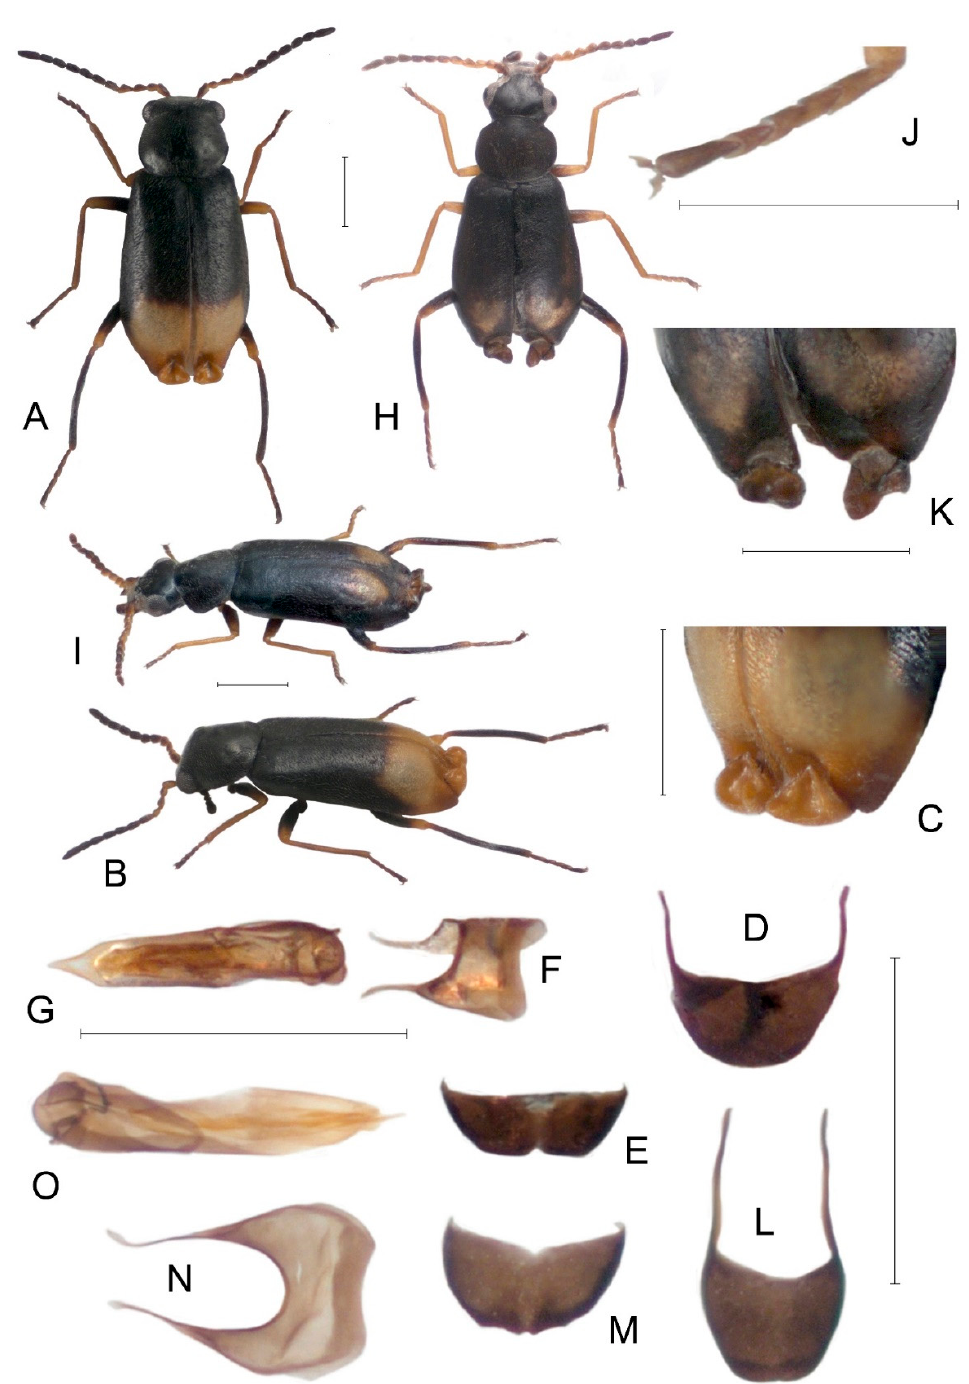
Figure 1. Hypebaeus (Hypebaeus) flavipes (Fabricius, 1787), (male) ( A – G ) and Hypebaeus (Hypebaeus) cooteri Tshernyshev, sp. nov. (holotype, male) ( H – O ). ( A , B , H , I ) External appearance. ( C , K ) Elytral apices. ( D , L ) Pygidium (apical tergite). ( E , M ) 8th ultimate abdominal ventrite (apical sternite). ( F , N ) Tegmen. ( N , O ) Aedeagus. ( J ) Left anterior tarsus. Scale bars 0.5 mm. Material. Holotype, male: Russia, Khabarovskii Krai: Botchinsky Nature Reserve, right bank of Mulpa river, near Komarov kluch river, h~220 m above see level, 48 ◦ 16 (cid:48) 35 (cid:48)(cid:48)